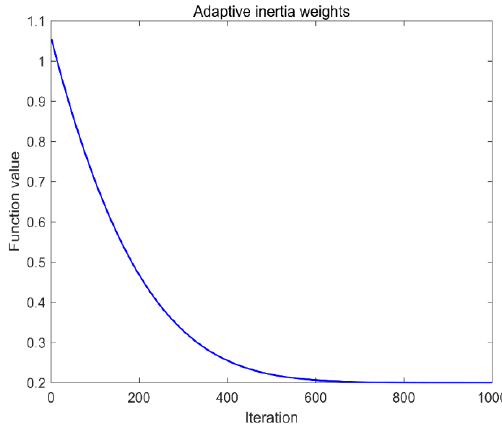
Figure 1. The plot of Adaptive Weights.